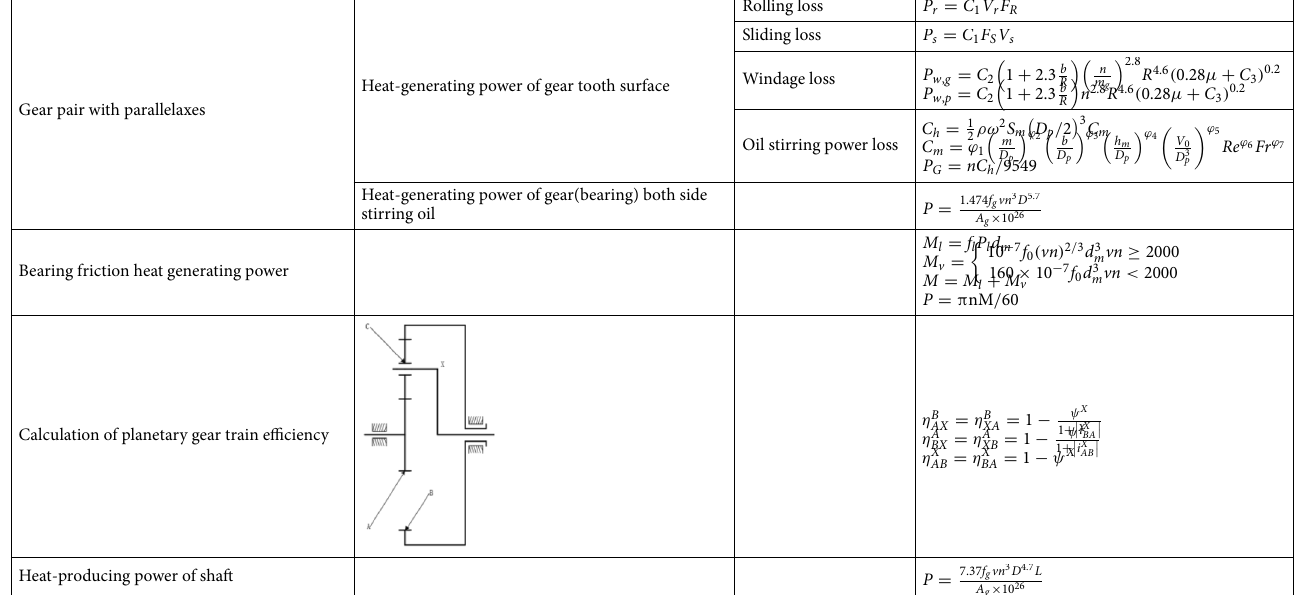
Table 2. Calculation formula of heat production of gearbox.